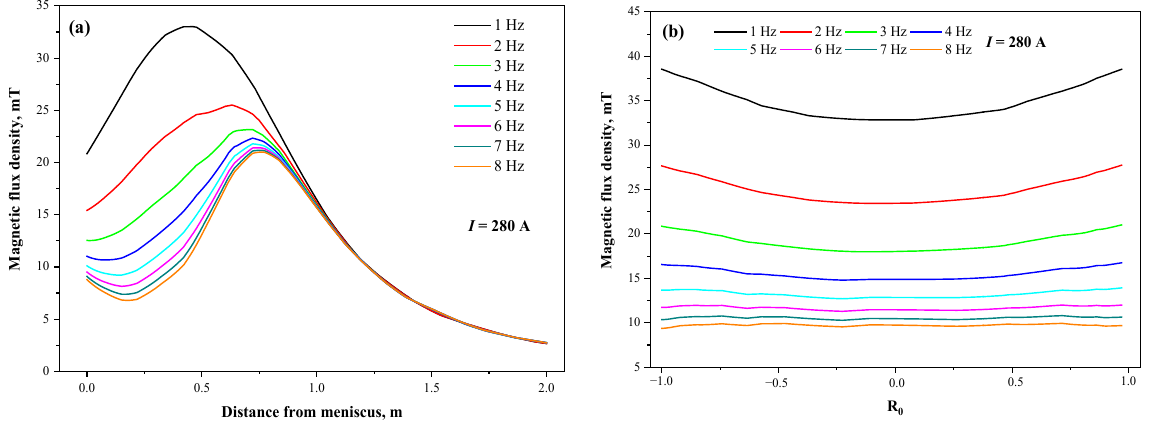
Figure 8. Magnetic flux density distribution at different current frequencies: ( a ) vertical center line; ( b ) horizontal radial line.